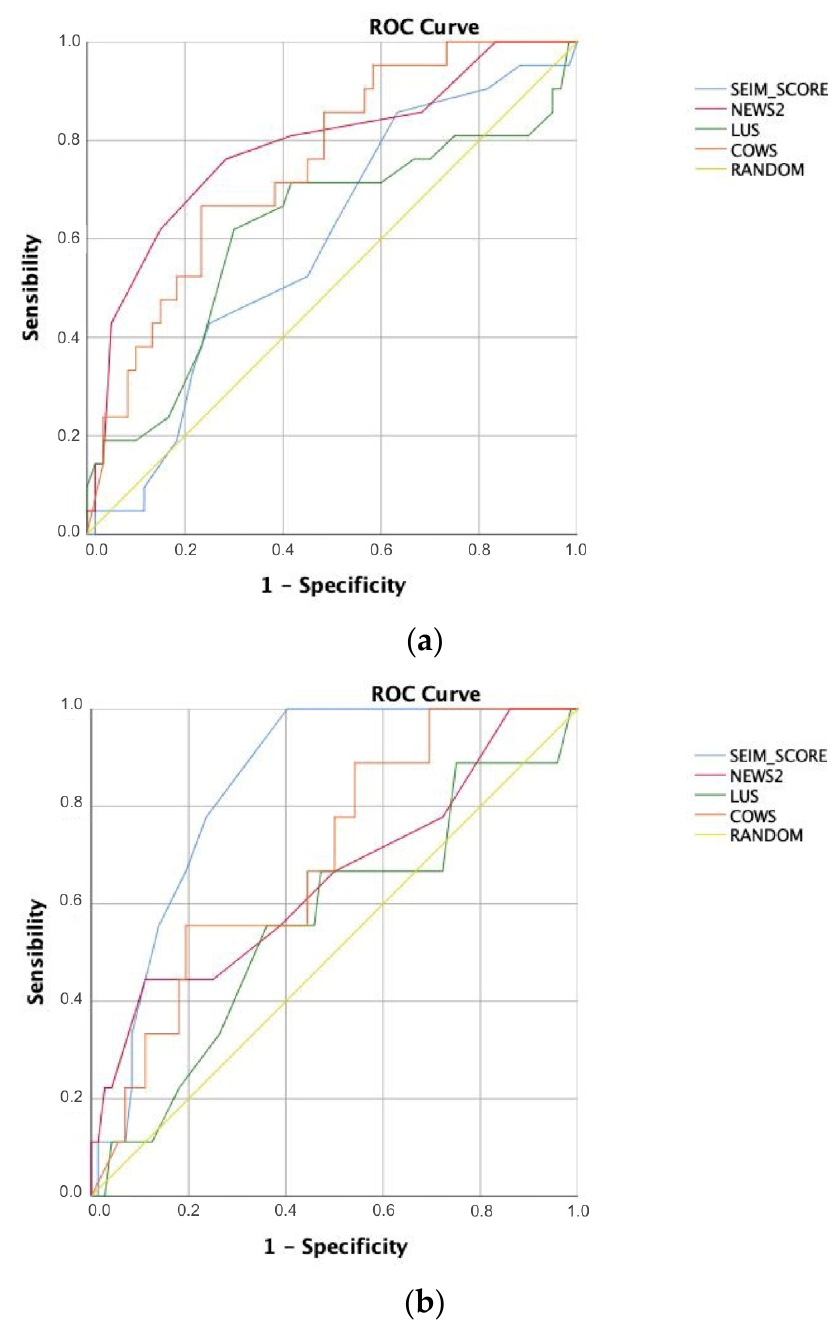
Figure 3. Pooled ROC curves for ( a ) poor outcome and ( b ) dead at 28